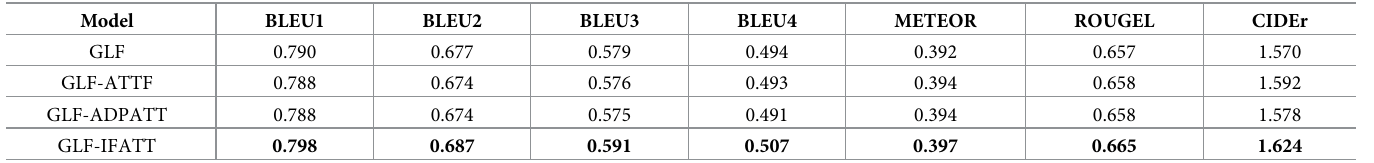
Table 1. Evaluation scores of attention mechanism comparison experiment.